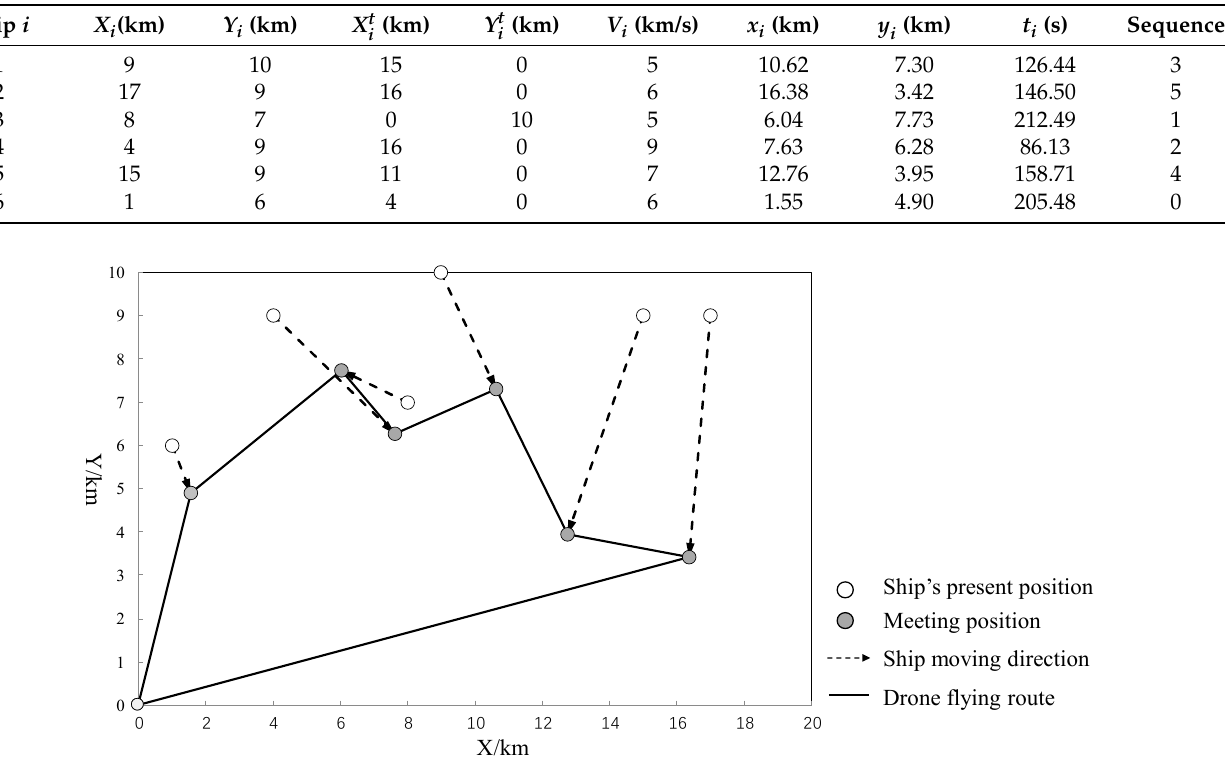
Table 4. Demonstrate the results of case-solving.